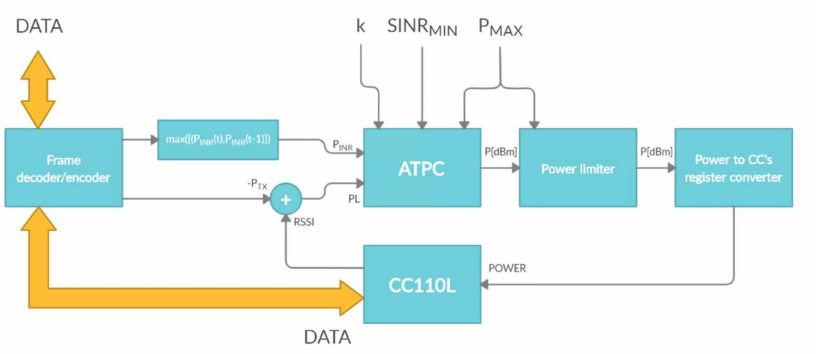
Figure 7. Block diagram of the automatic transmitter power control (ATPC) algorithm working with